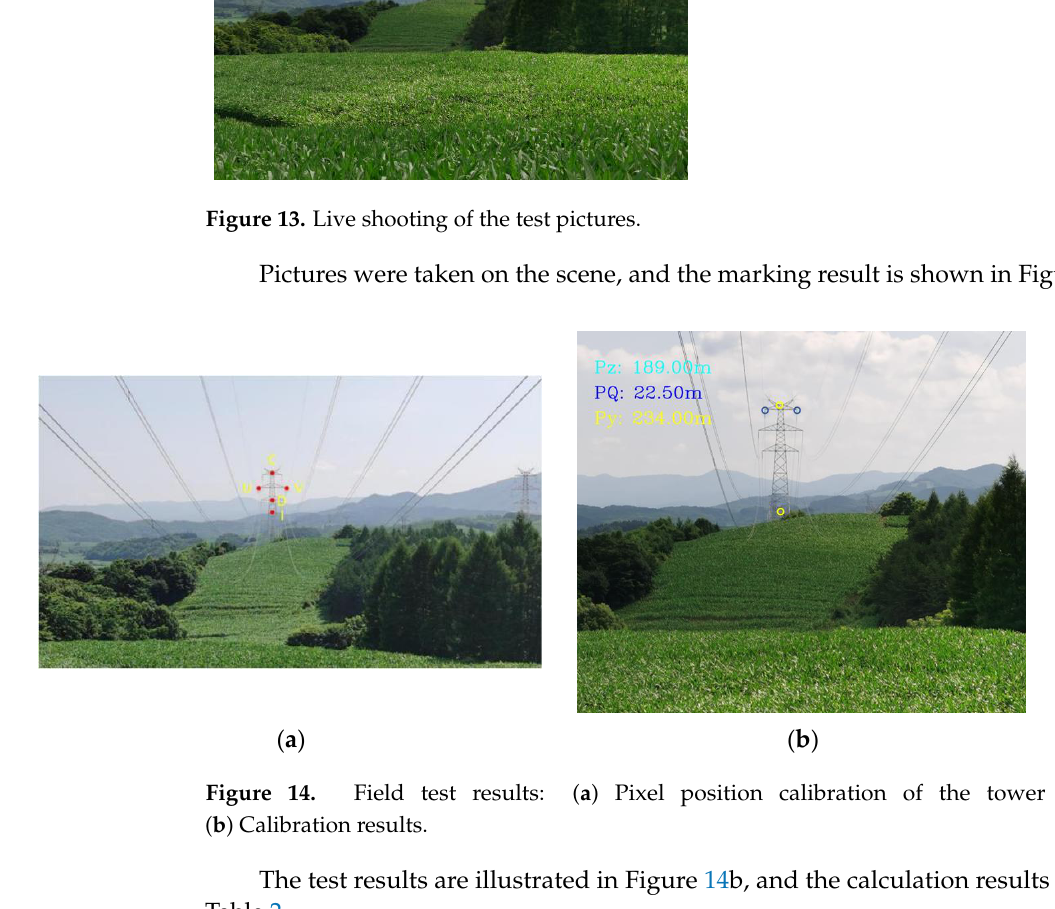
Figure 13. Live shooting of the test pictures.